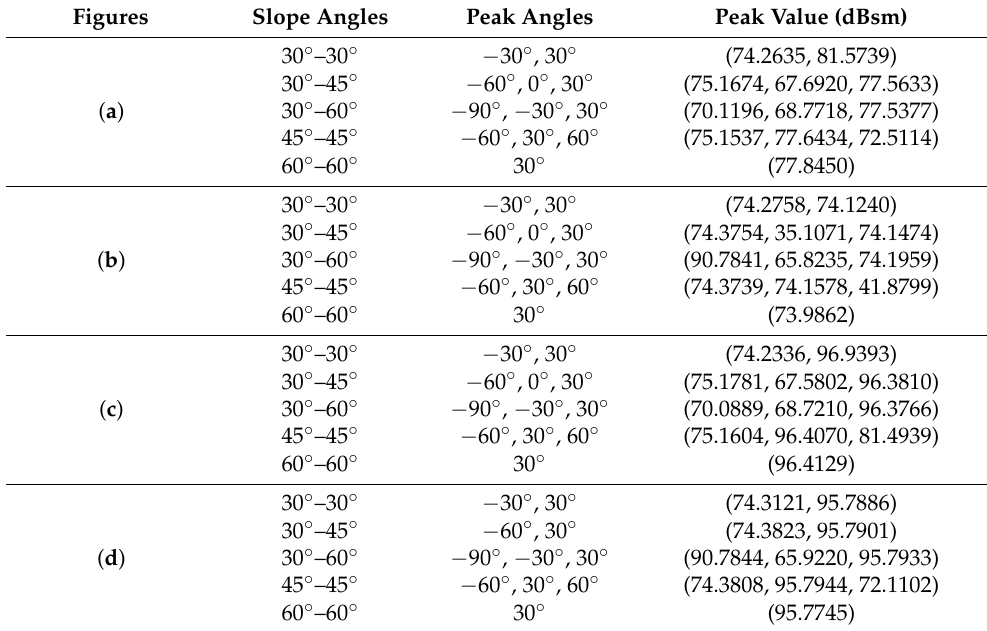
Table 2. Peak values of different slope-angle combinations.